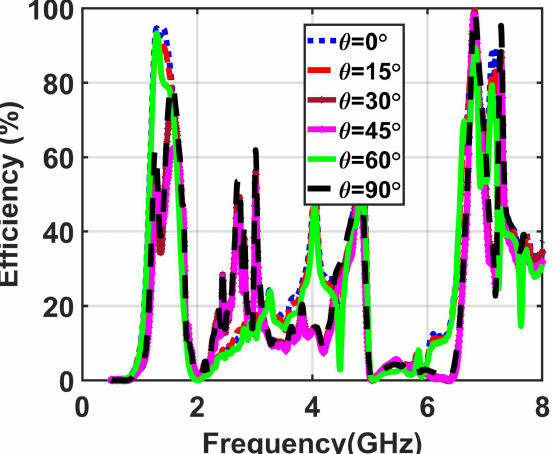
Figure 13. Obtained results demonstrating the efficiency with various incident angles of the imple- mented 8 × 8